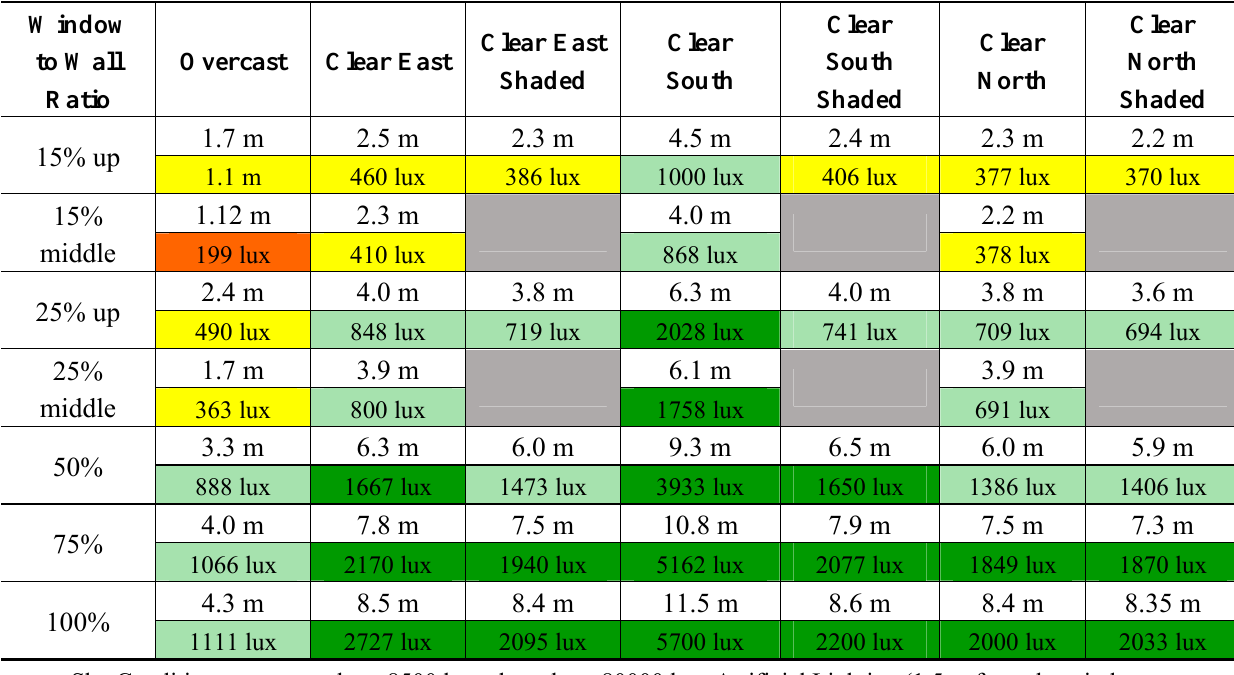
Table 3. Depth of passive zone according to daylight penetration along the year, correlated with artificial light requirements.